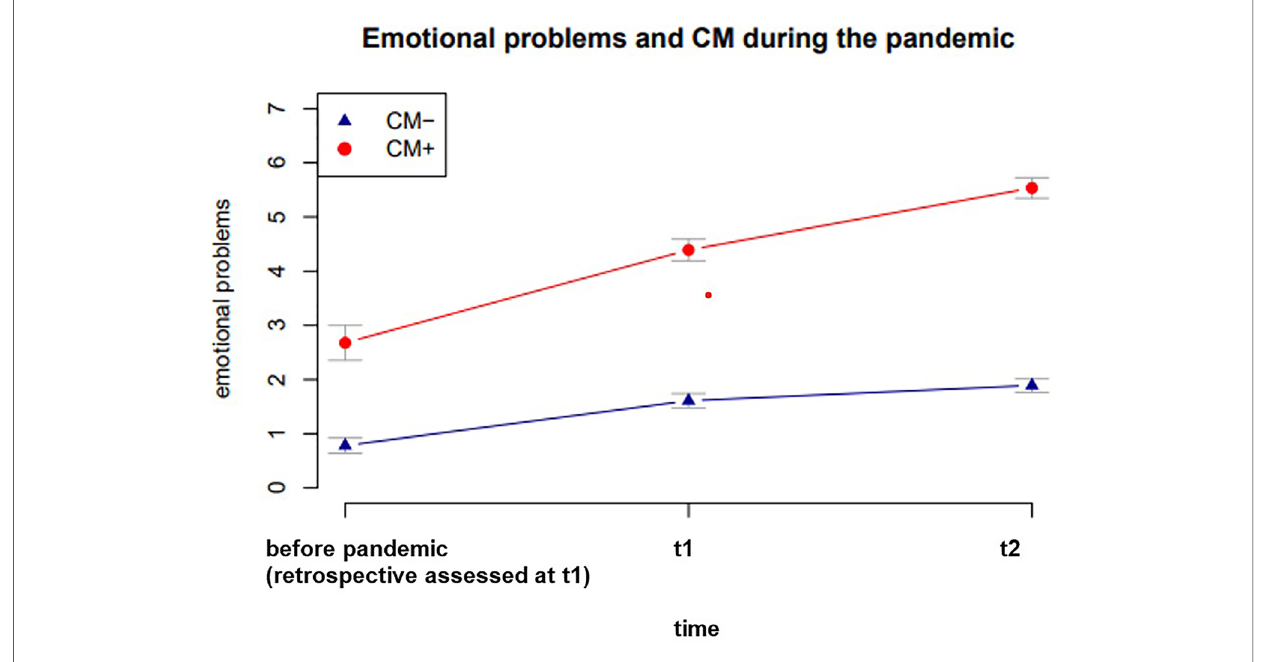
FIGURE 1 Means of children ’ s emotional problems as a function of CM and the SARS-CoV-2-pandemic with standard